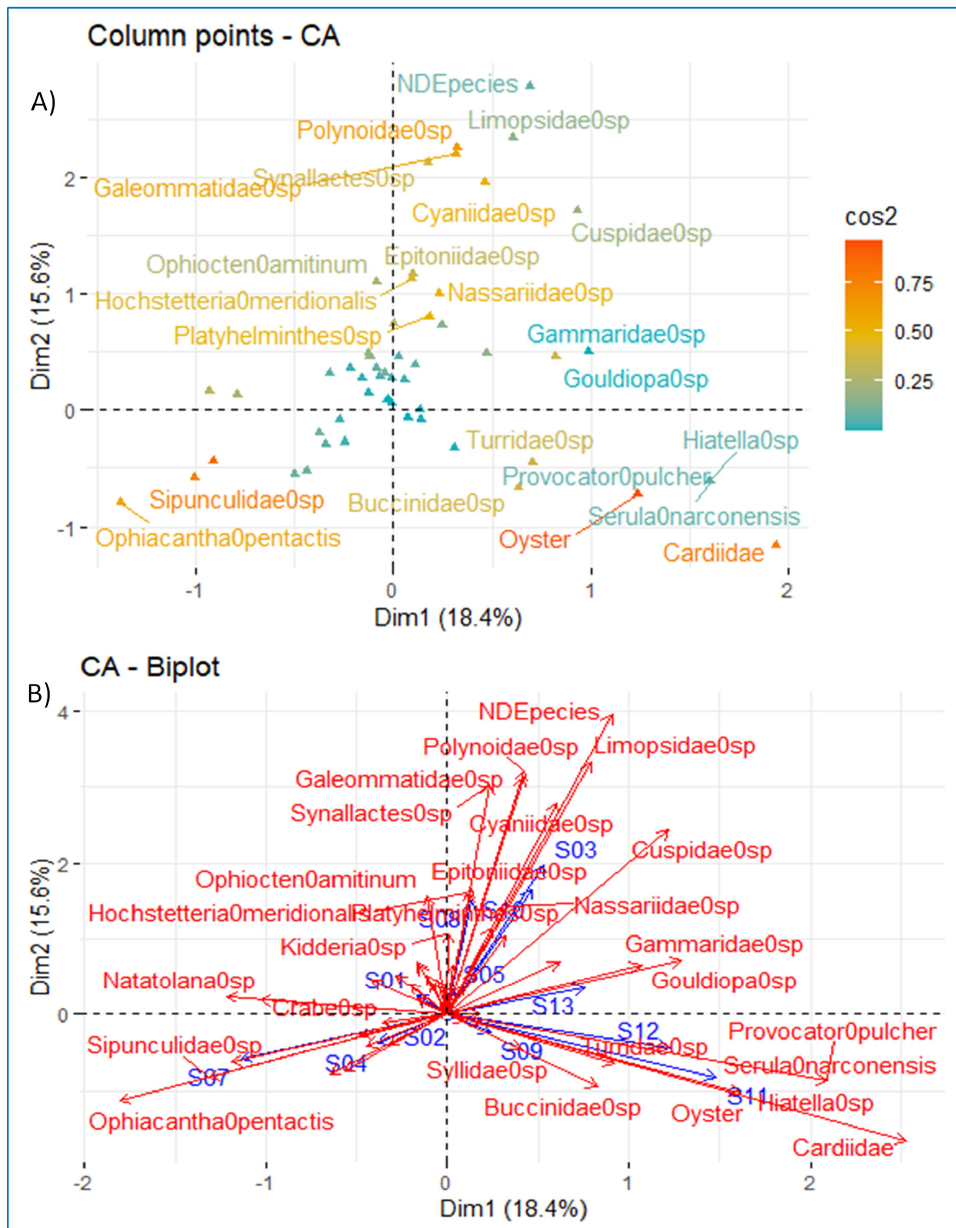
Figure 6. ( A ) Correspondence factorial analysis (CFA) results showing the distribution of benthic species and ( B ) correlation between sampling stations and species on the dissensions 1 and 2 of the factorial plan. Group 1 is characterized by Ophiacantha pentactis and Sipunculidae sp. , and to a lesser extent, Natalano sp. and Lithodes murrayi (Crab sp. ), whereas Group 2 is mainly character ‐ ized by Kidderia sp. , Platyhelminthes sp., Epitoniidae sp., Syllidae sp. , Nassariidae sp., Buccinidae sp., Gammaridae sp., and Goudiopa sp. ( Figure 6B) . Group 3 is marked by Polynoidae sp. , Limopsidae sp. , Geommatidae sp. , Cyaniidae sp. , Cuspidae sp., and EDSpecies